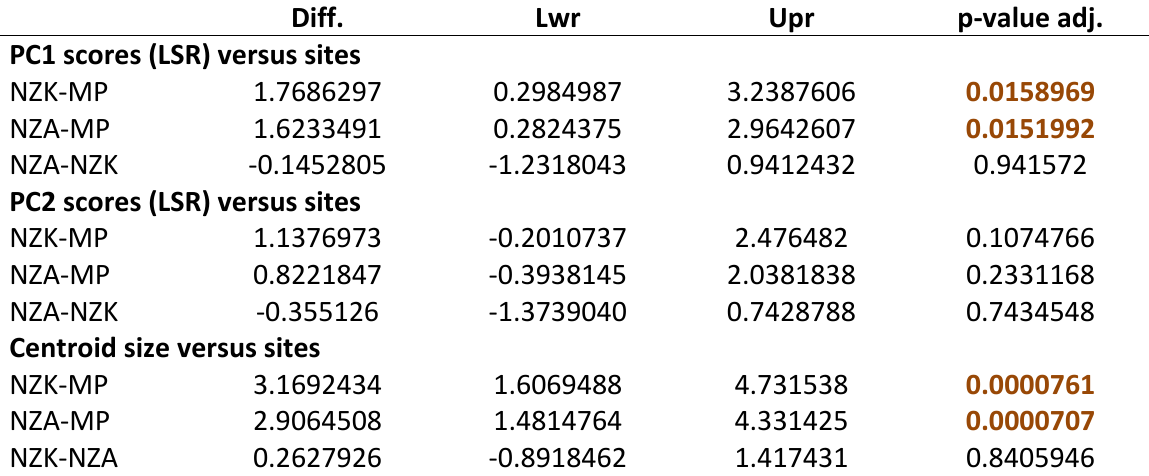
Table 12. Results of the post-hoc Tukey HSD test conducted on PC1-PC2 scores (LSR) and centroid size versus sites for the Lupemban point assemblages. Significant values are shown in bold. diff. : difference in the observed means, lwr : lower end point of the interval, upr : upper end point of the interval, p-value adj : p-value after adjustment for the multiple comparisons.